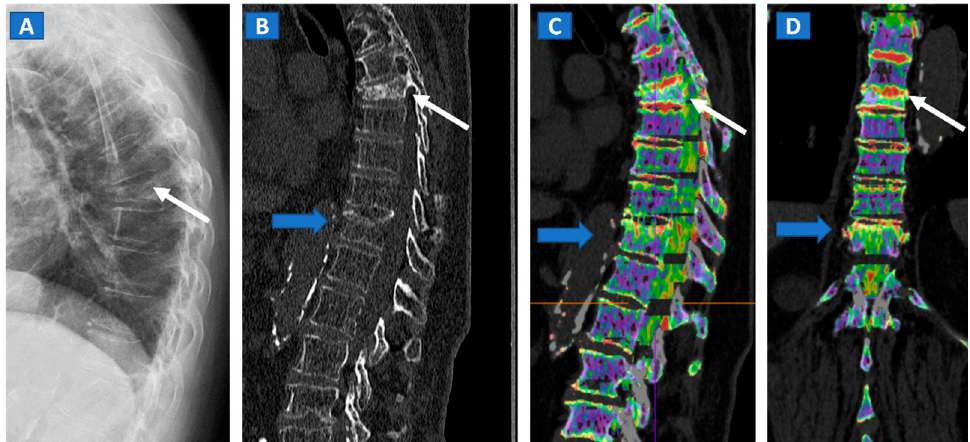
Figure 1. An 82-year-old female, unable to undergo MRI, with non-traumatic dorsal vertebral compression fractures. On the sagittal standard radiograph ( A ) a mid-dorsal spine fracture can be seen (white arrow). On the high resolution sagittal 1 mm reconstructed CT image ( B ), an additional fracture of the D9 vertebral body is suspected (blue arrow). On the corresponding sagittal ( C ) and coronal DECT superimposed map ( D ), D5 and D9 fresh vertebral fractures are confirmed by the presence of BME, coded in shades of green (arrows), while normal bone is coded in violet.